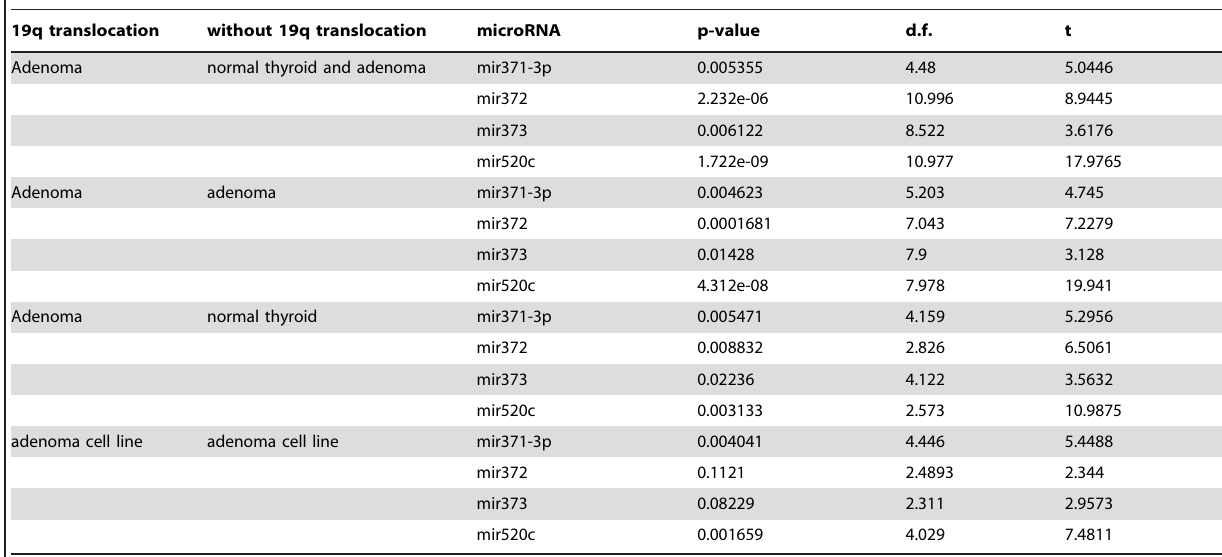
Table 2. Statistical analysis of the qRT-PCR